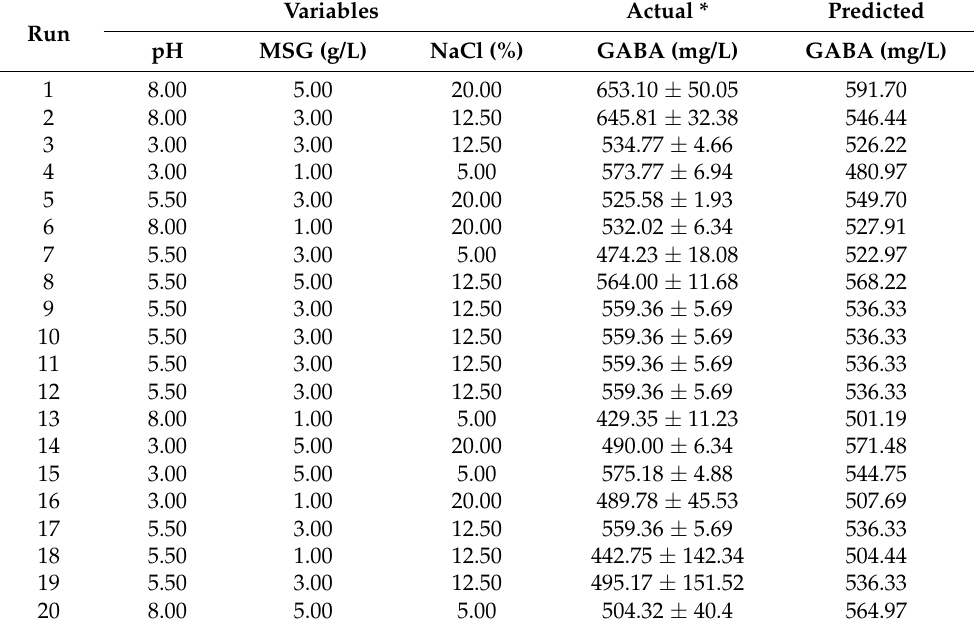
Table 2. Box–Behnken design of the three selected factors and the generation of predicted and actual GABA yield (mg/L) of T. halophilus strain